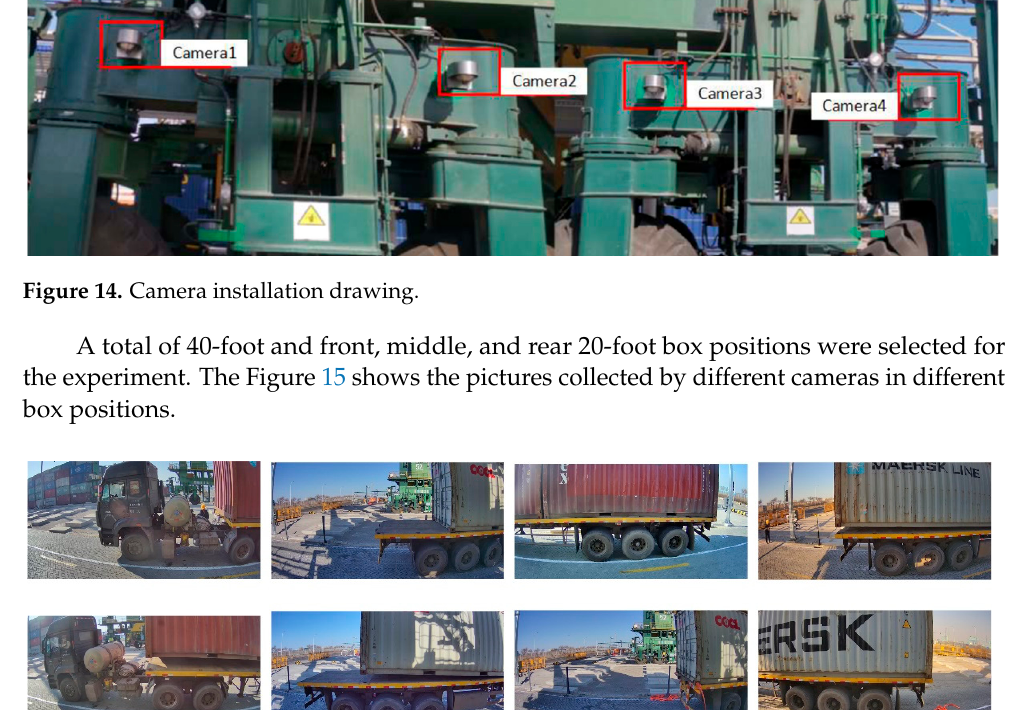
Figure 15. Part of the dataset images.